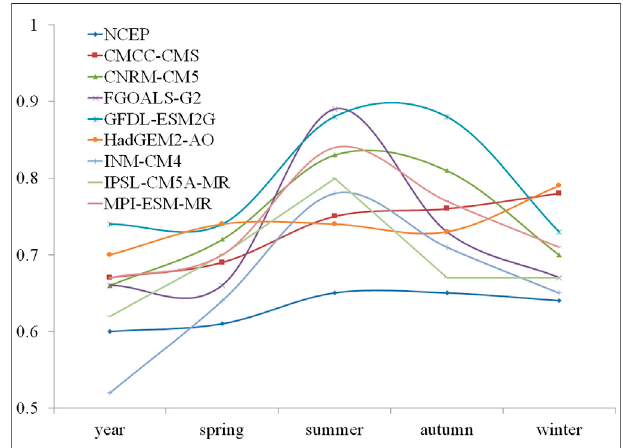
FIGURE 3 | The scaling exponents of SAT from NCEP and CMIP5 models at the point of (110 ° E, 23 ° N) for year and all four seasons.